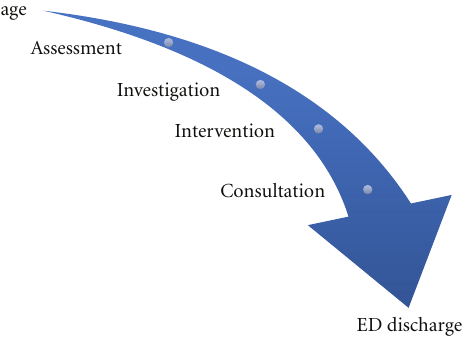
Figure 2: Analysis of processes required for the assessment and management of a patient presenting to the emergency department.